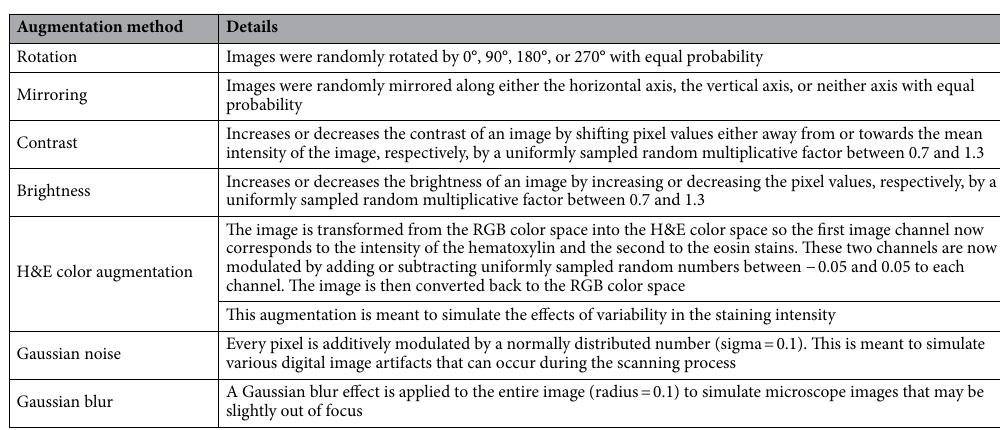
Augmentation method